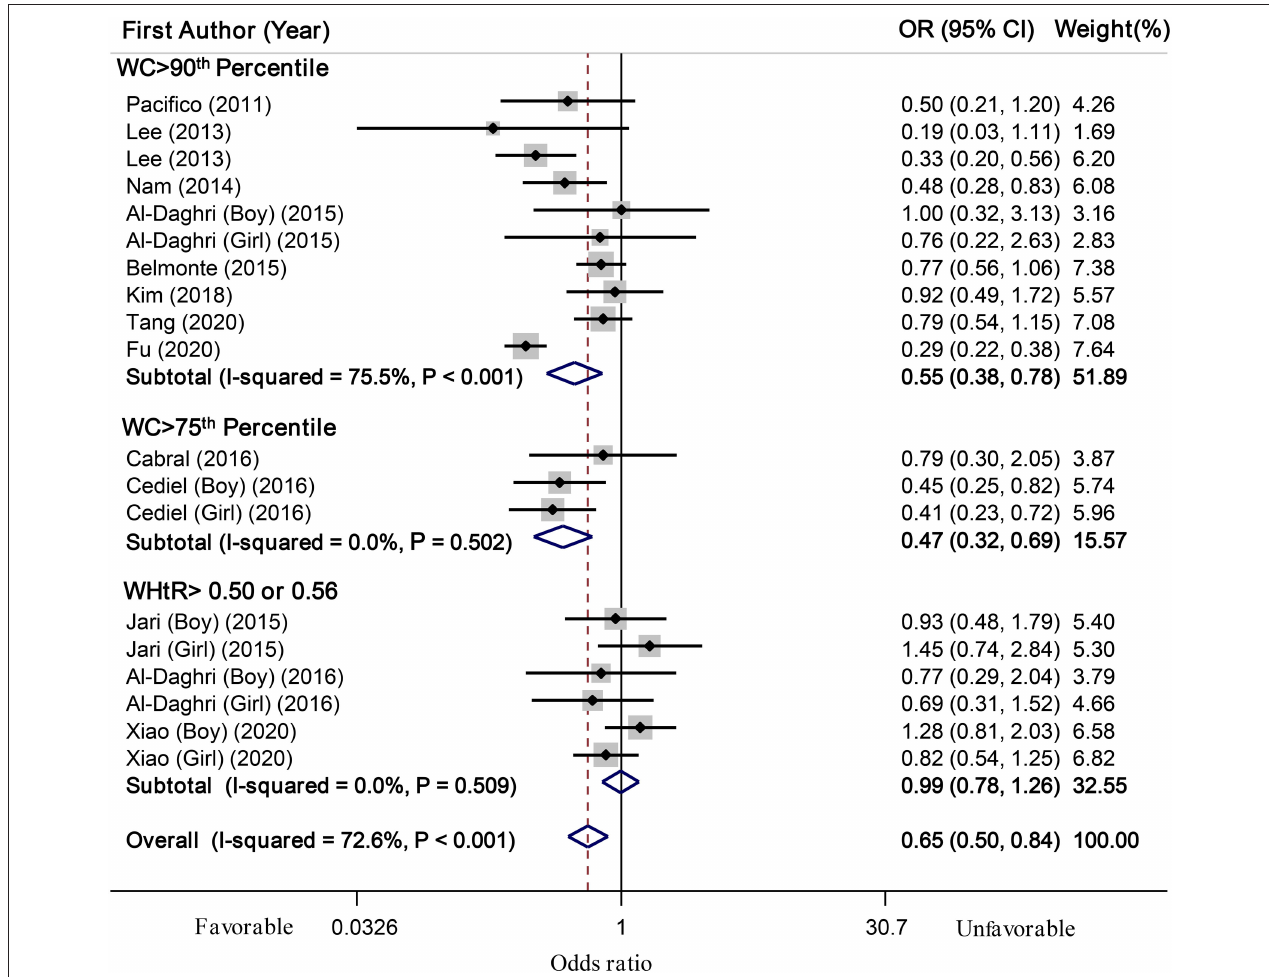
FIGURE 2 | Forest plots of the relationship between serum vitamin D levels and abdominal obesity in children and adolescents, stratified by abdominal obesity